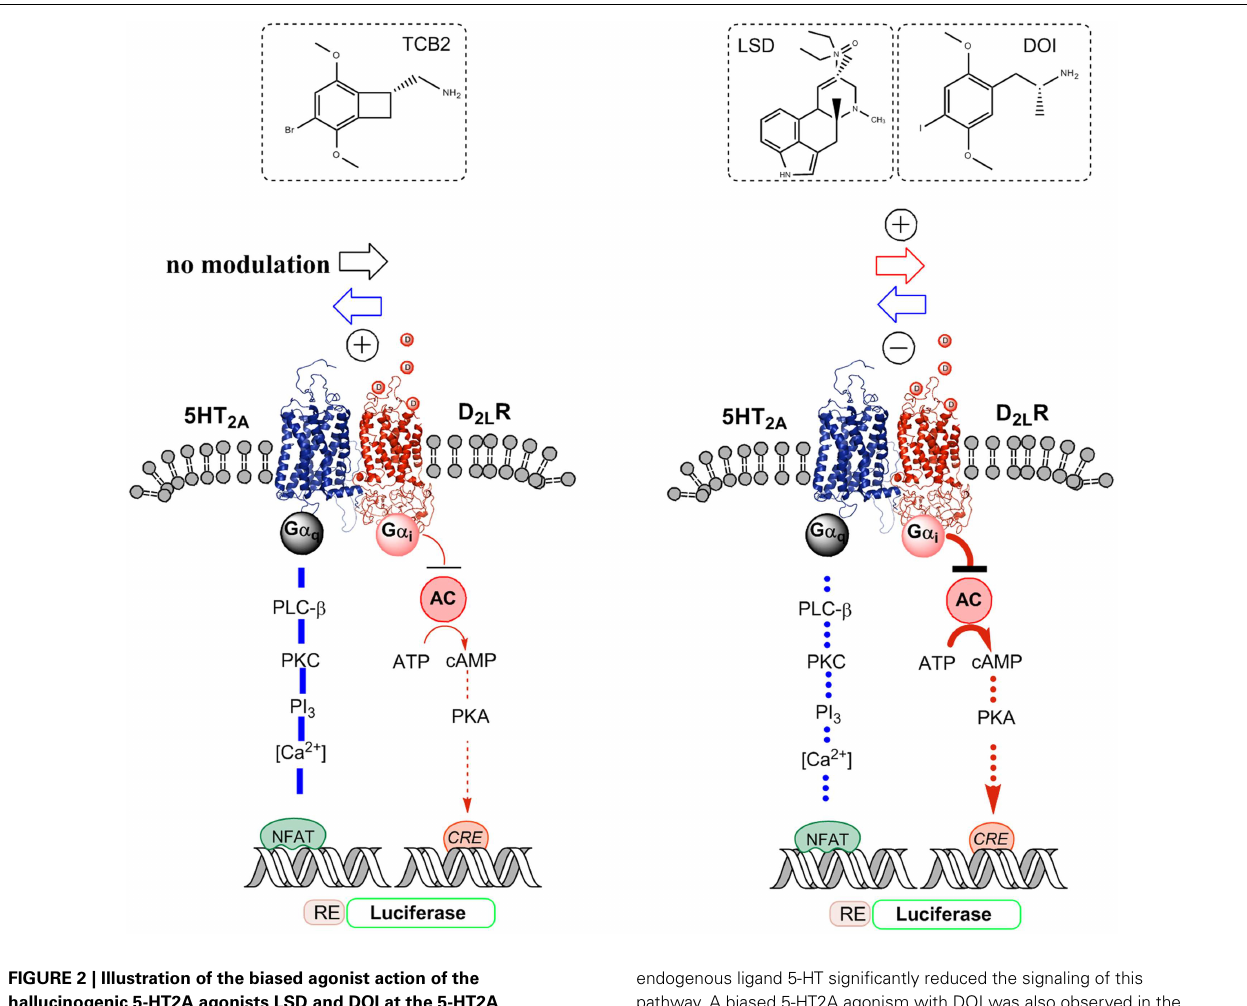
endogenous ligand 5-HT significantly reduced the signaling of this pathway. A biased 5-HT2A agonism with DOI was also observed in the facilitatory D2LR–5-HT2A receptor–receptor interaction of the heteromer, which enhances 5-HT2A signaling over Gq/11–PLC when using 5-HT and TCB2 as 5-HT2A agonists.Thus, when using DOI as a 5-HT2A agonist, a D2R agonist instead diminished 5-HT2A protomer signaling over the Gq/11–PLC